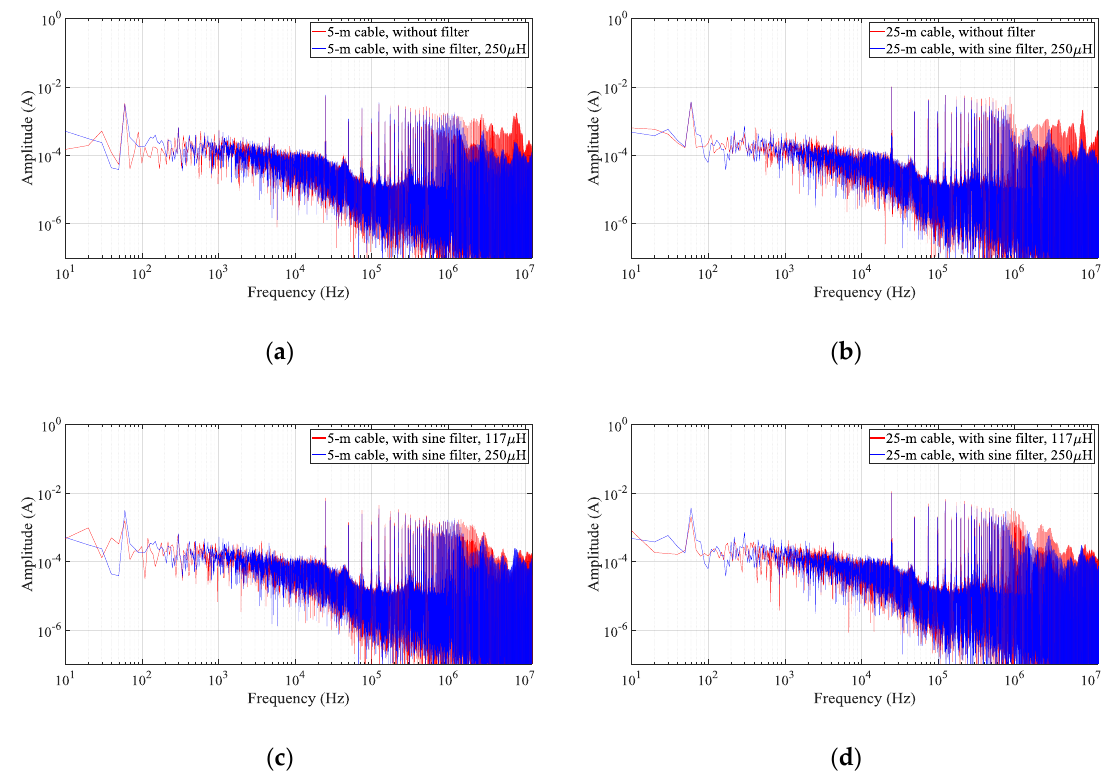
Figure 12. Frequency spectrum comparison of common mode current with and without sine filter. ( a , c ) 5-m cable length and ( b , d ) 25-m cable length.